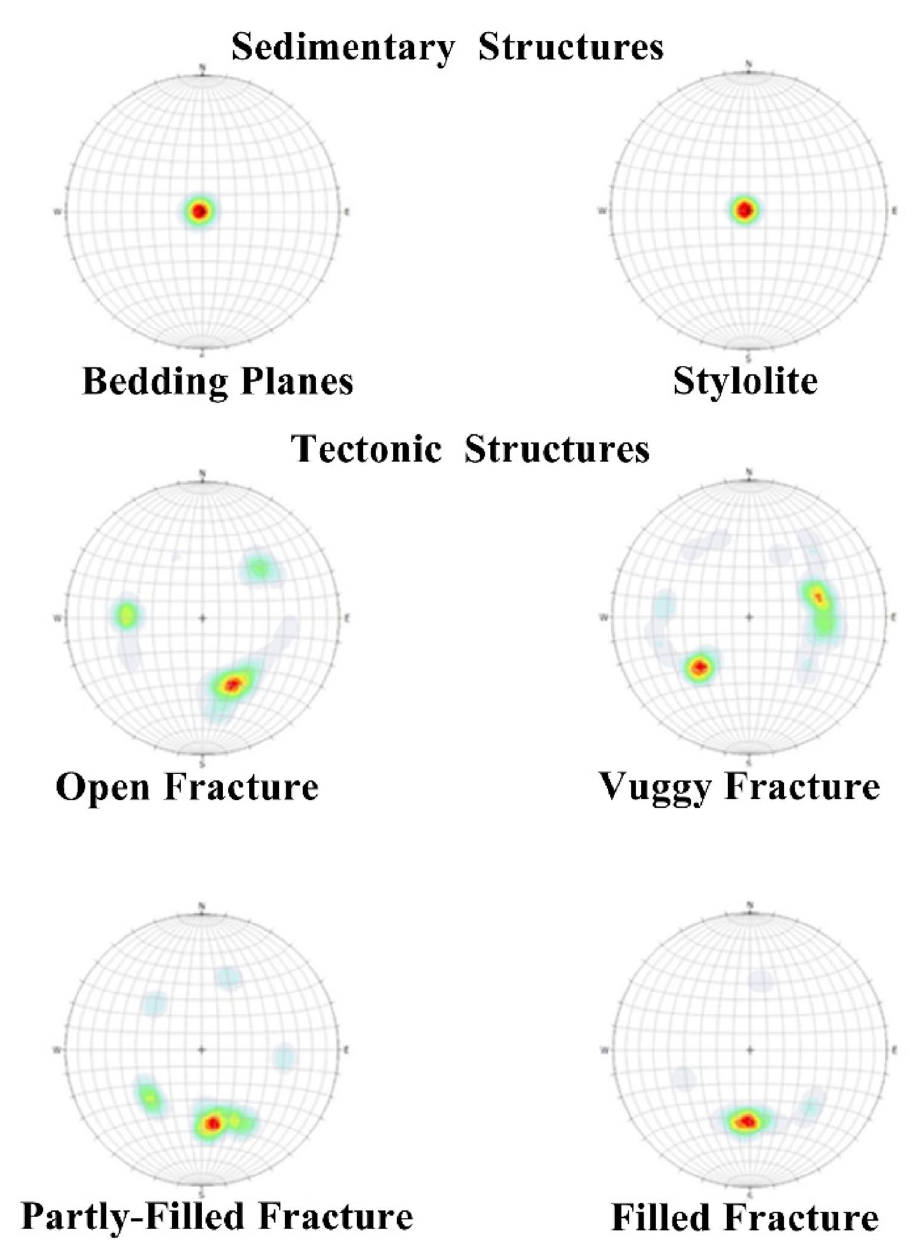
Fig. 8 Lower-hemisphere pole projection for all fractures, stylolites and bedding